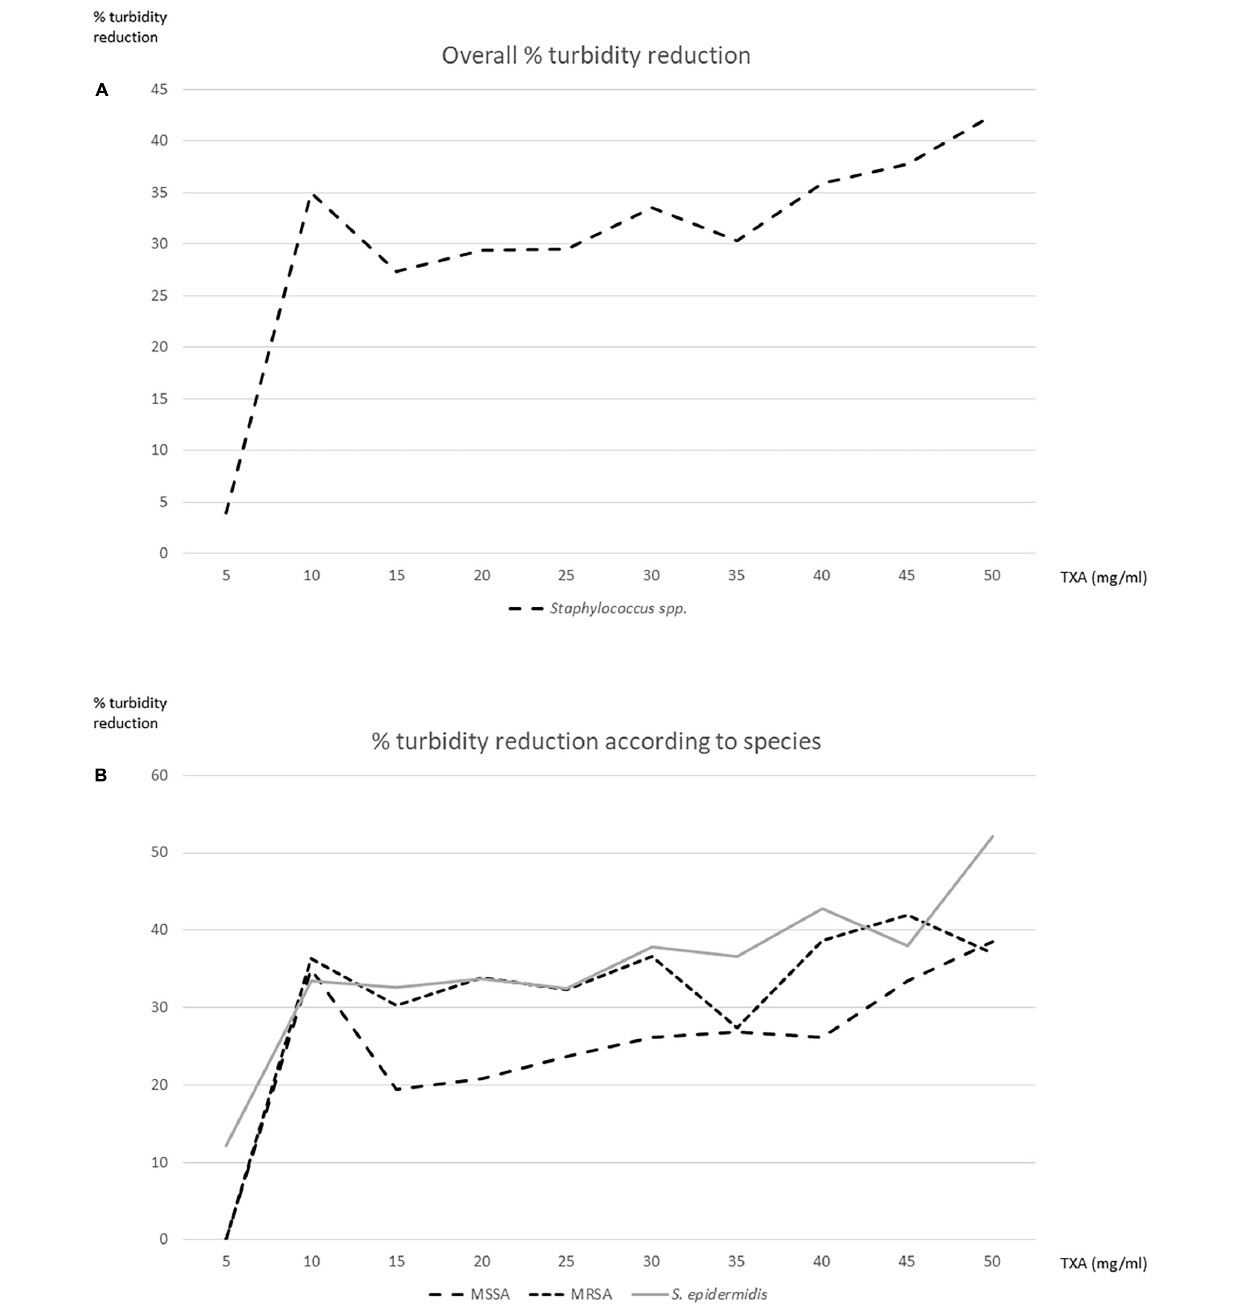
FIGURE 1 | Percentage reduction in well turbidity after testing tranexamic acid (TXA) serial dilutions against planktonic bacteria. (A) Overall. (B) According to species.